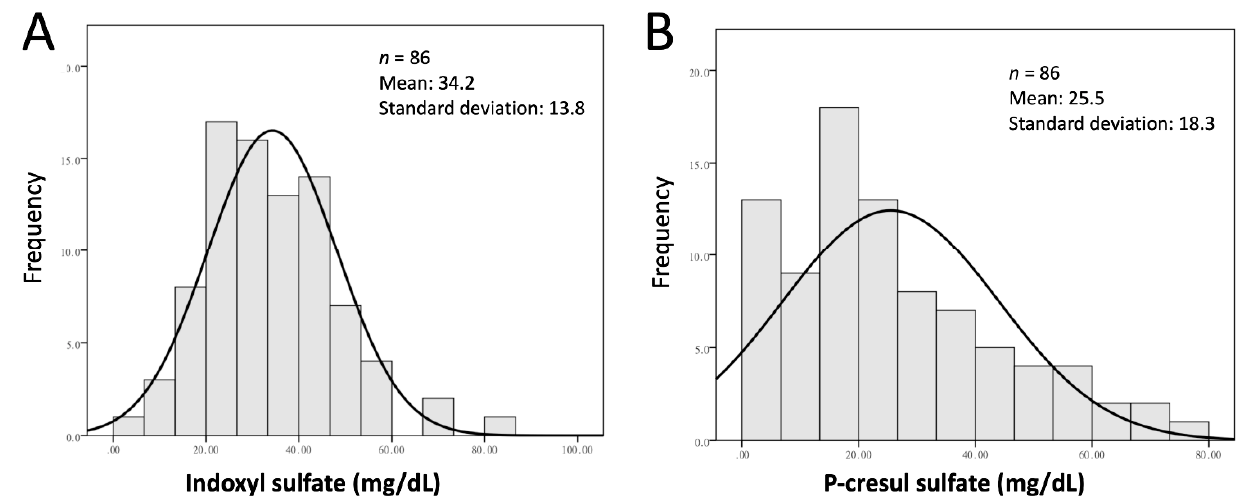
Figure 2. Distribution of serum levels of indoxyl sulfate ( A ) and P-cresyl sylfate ( B ). Table 1. Clinical demographic and biochemical characteristics related to indoxyl sulfate and p-cresyl sulfate concentra- tions.